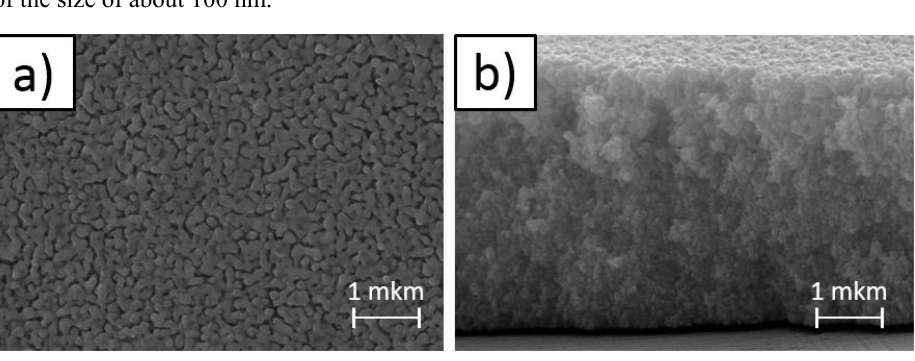
Fig. 4. SEM images of surface (a) and cleavage (b) of the